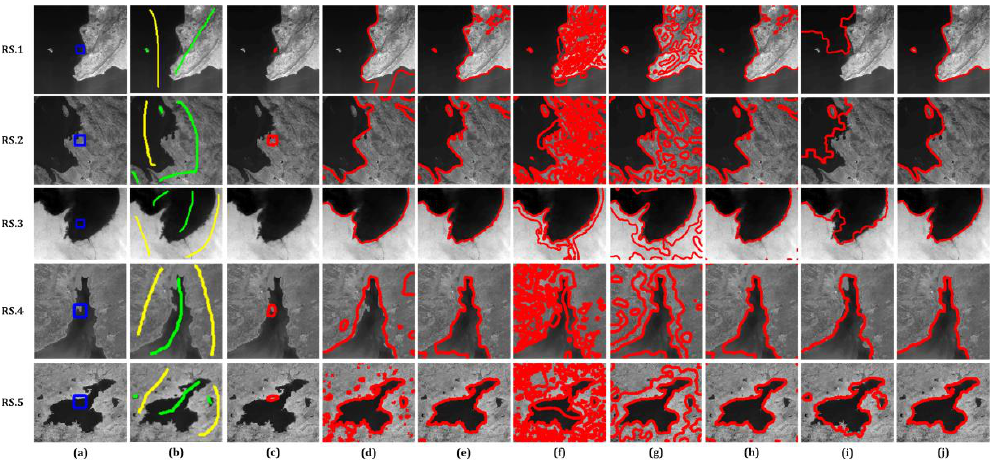
Figure 9 . Segmentation results of remote sensing image database: ( a ) initial contour of level set methods; ( b ) initial makers of MSRM; ( c ) GAC; ( d ) CV; ( e ) SBGFRLS; ( f ) LBF; ( g ) ILFE; ( h ) Cao’s model; ( i ) MSRM; ( j ) the proposed method.